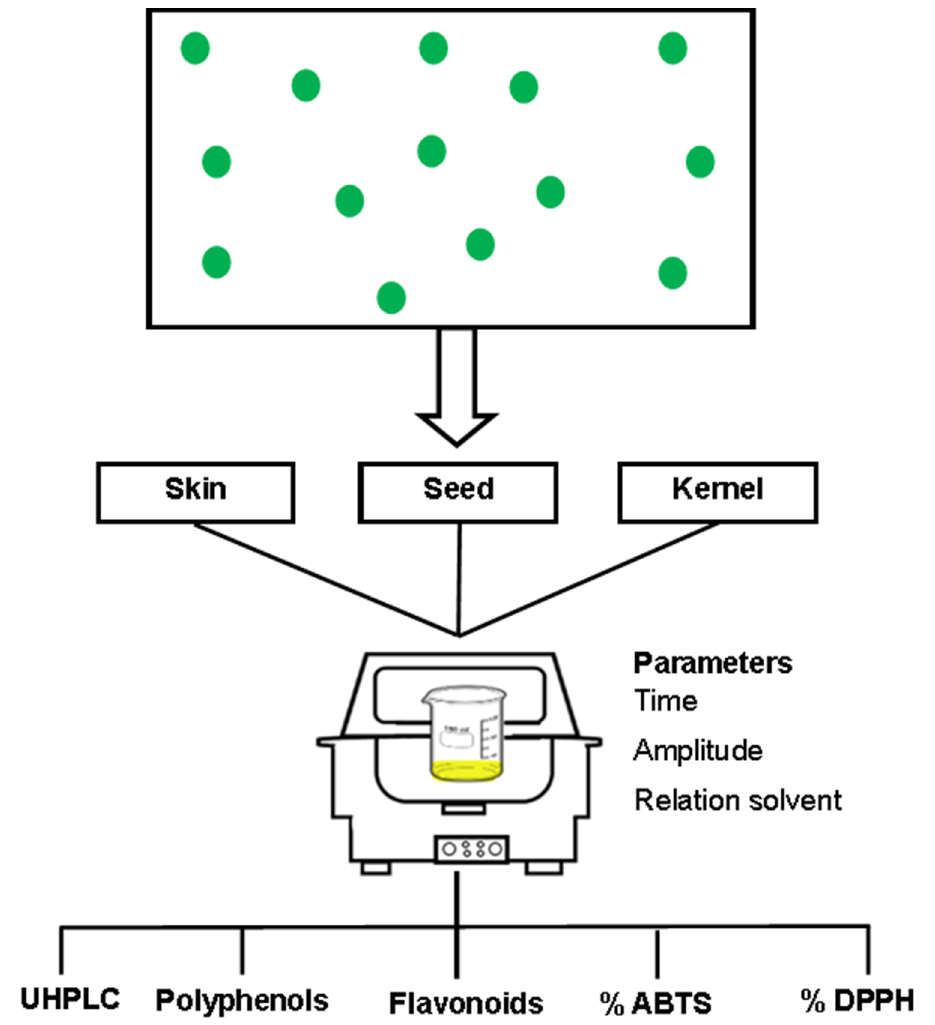
Figure 1. Graphical scheme of sampling procedures.